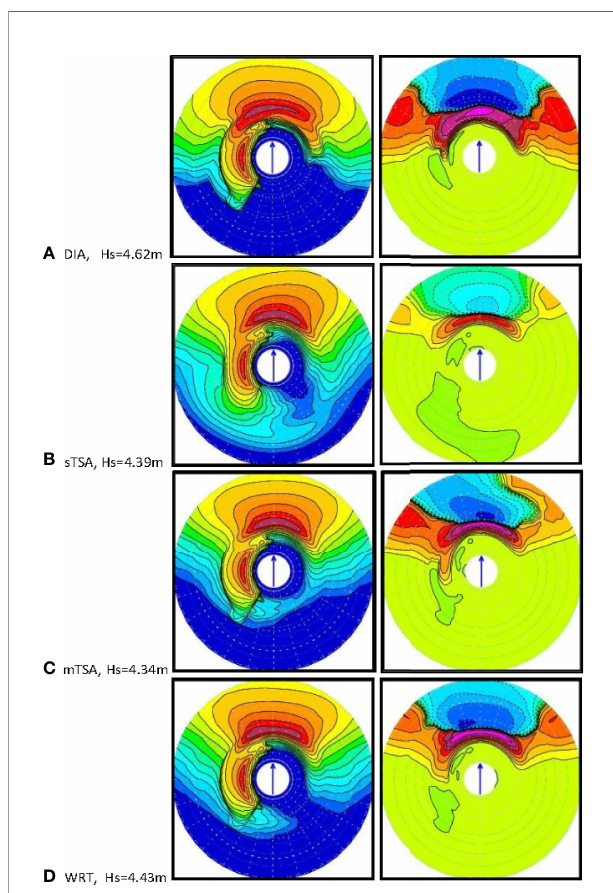
FIGURE 4 | Evolving spectra starting with initial conditions as Figure 1 , after time of 5 hours evolution, with 20m/s wind to the north and ST4 source terms: (A) DIA, (B) single-TSA, or sTSA, (C) multiple TSA, or mTSA, (D) WRT, showing 2-D energy in the left column and 2-D S nl in the right. Hs (m) as indicated. Same color bars and scales as Figure 1 . Hs is